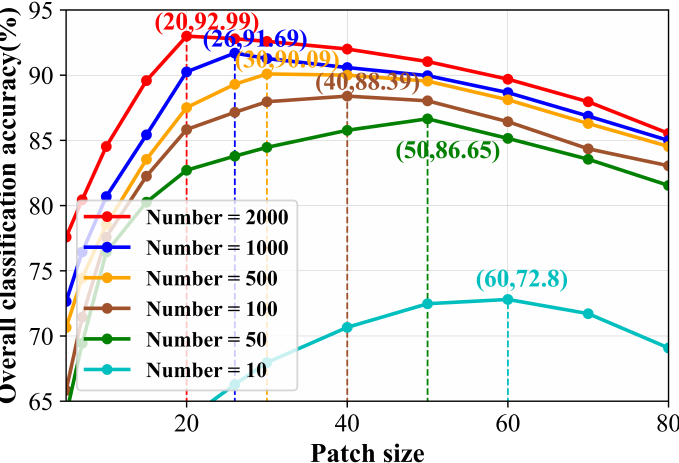
Figure 8. The overall classification accuracy varies with patch sizes when there are different labeled samples applying ResNet on Rs2-Sanf